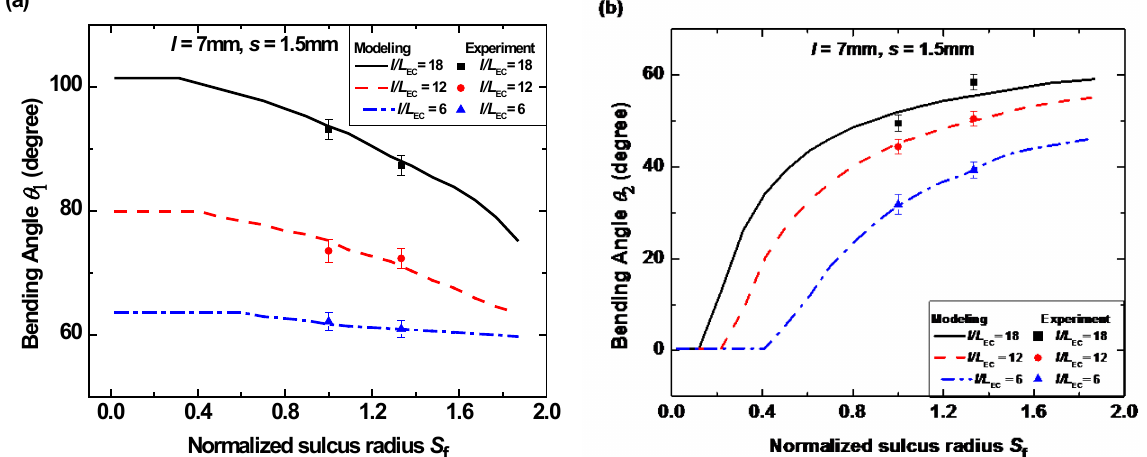
Figure 15. Modeling and experimental results of the bending angles ( a ) θ function of the sulcus length factor